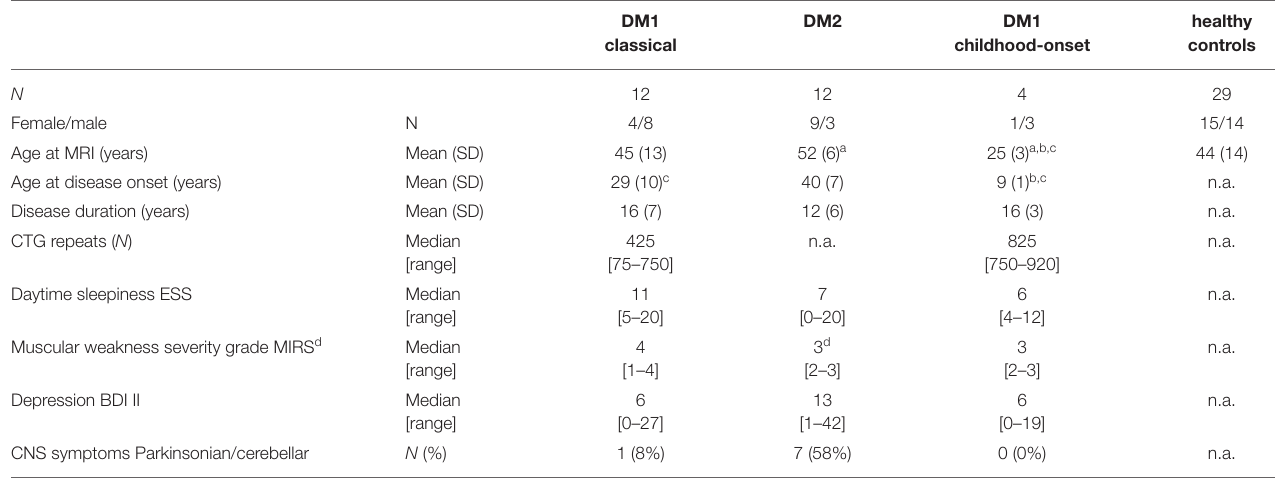
TABLE 1 | Demography of patients and controls and the clinical